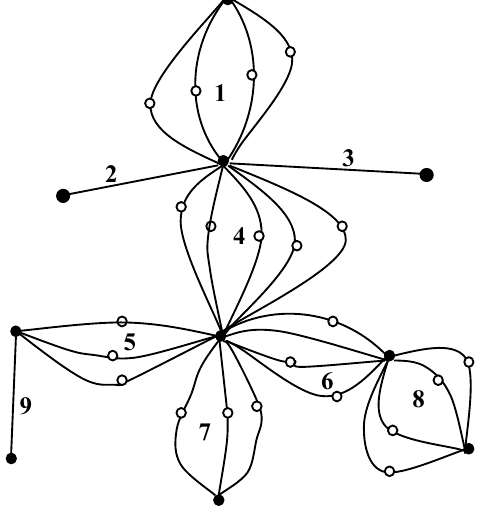
Figure 2. Virtual graph of the